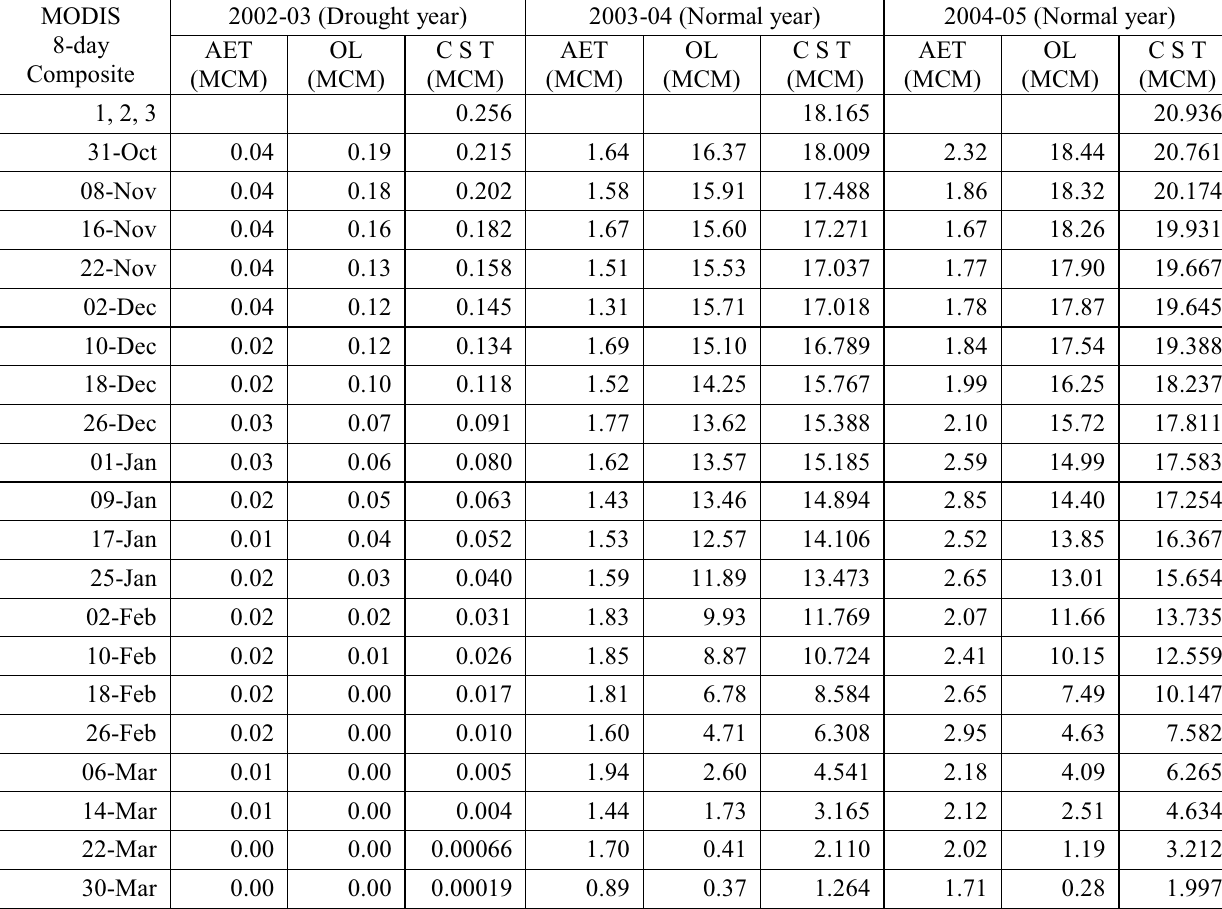
Change in storage, actual evapotranspiration and other loses in the Nalsarovar